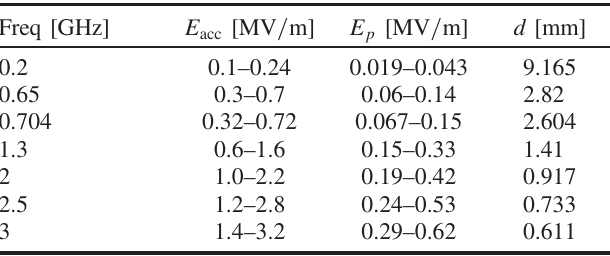
TABLE I. The local peak electric field E p and local gap d of zone 1 MP in scaled TESLA-type cavities. E corresponding acceleration